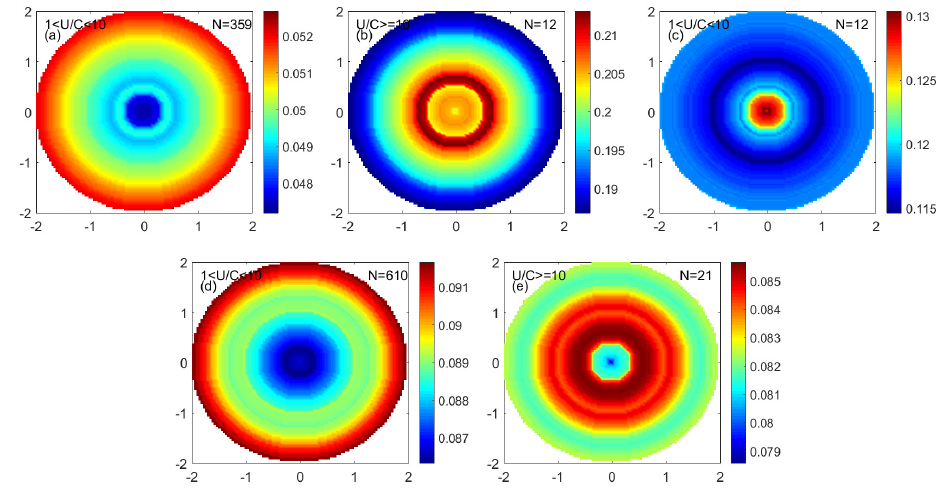
Figure 15. The monopole distribution of EKE in the eddy. ( a ) Low nonlinearity anticyclonic eddy. ( b ) High nonlinearity anticyclonic eddy. ( c ) Low nonlinearity mode-water eddy. ( d ) Low nonlinearity cyclonic eddy. ( e ) High nonlinearity cyclonic eddy. (Unit: m 2 /s 2 ).